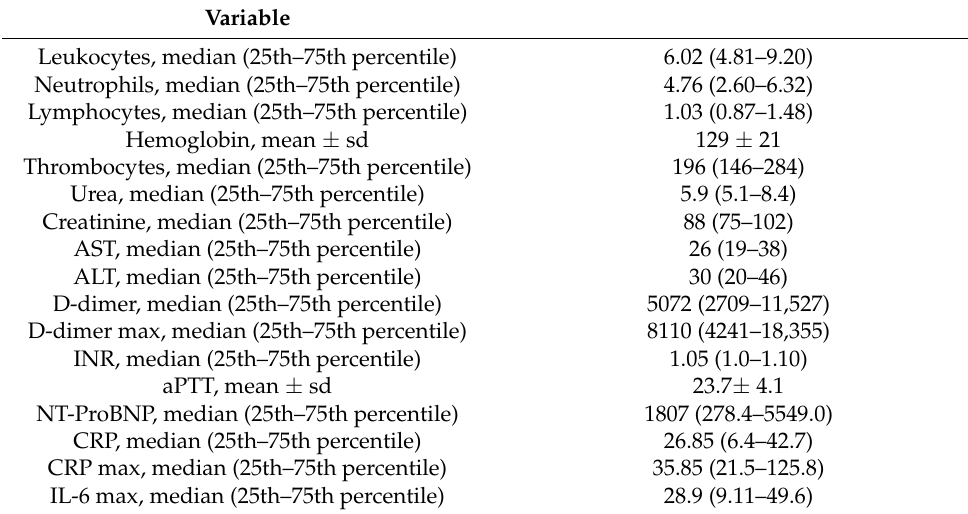
Table 3. Laboratory parameters of the study population.